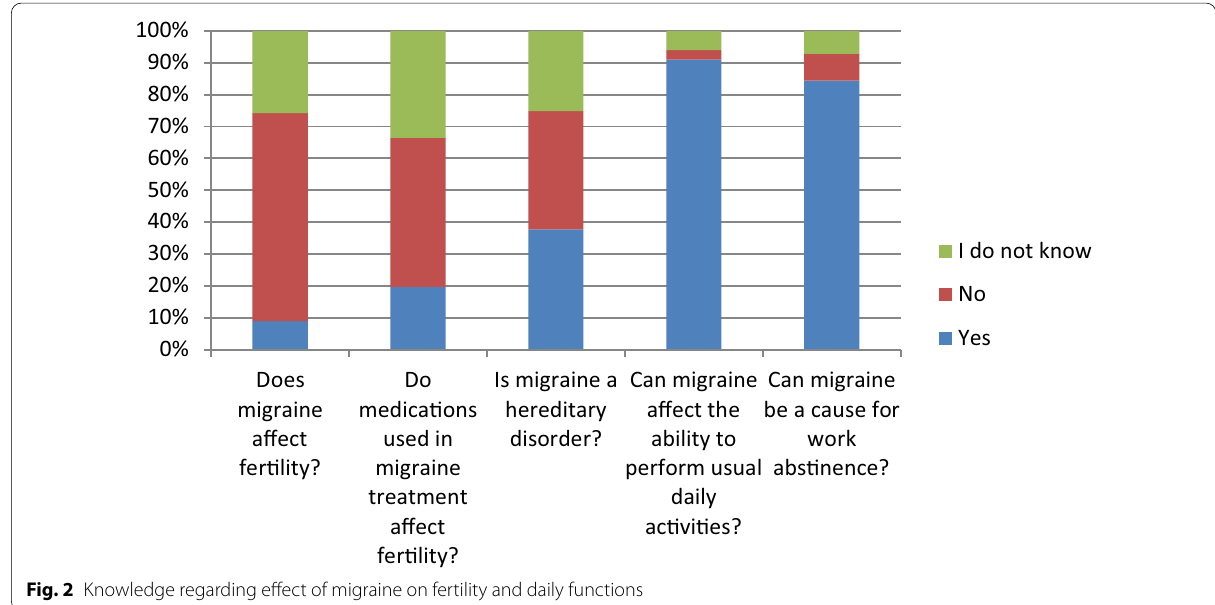
Fig. 2 Knowledge regarding effect of migraine on fertility and daily functions